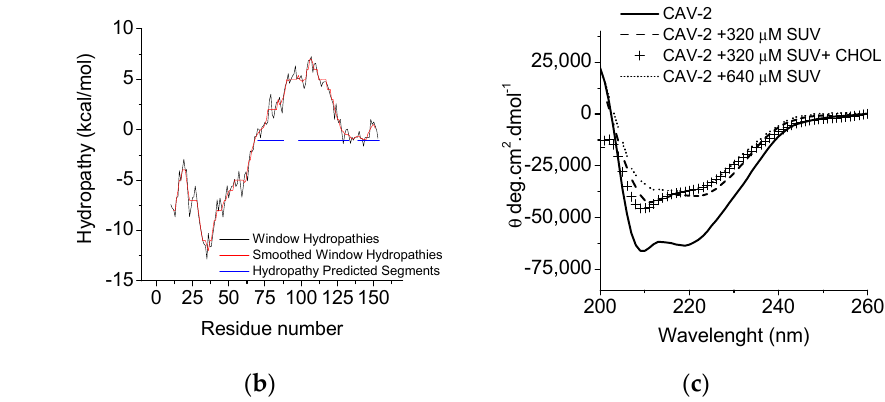
Figure 2. Prediction of intrinsically disordered and hydropathy segments and measurement of Cav-2 far-UV CD spectra in the presence of SUVs. Prediction of intrinsic disorder (panel a ) and hydropathy segments (panel b ) were calculated as indicated in the Materials and Methods using the sequence of alpha isoform of Cav-2. Far-UV CD spectra of Cav-2 measured in the presence of SUVs with different lipid compositions and concentrations are shown in (panel c ). Measurements were carried out at 25 °C with Cav-2 (32 μ M) in sodium phosphate buffer 25 mM at pH 7.0 (continuous line) or in the presence of SUVs (320 μ M), SUVs (320 μ M) + cholesterol 5% and SUVs (640 μ M) (crosses, dashed and dotted line, respectively). CD spectra were recorded 205 to 260 nm (far-UV), using a quartz cell of 0.1 mm, respectively. The DSC spectra shown in this figure are representative of triplicate experiments.